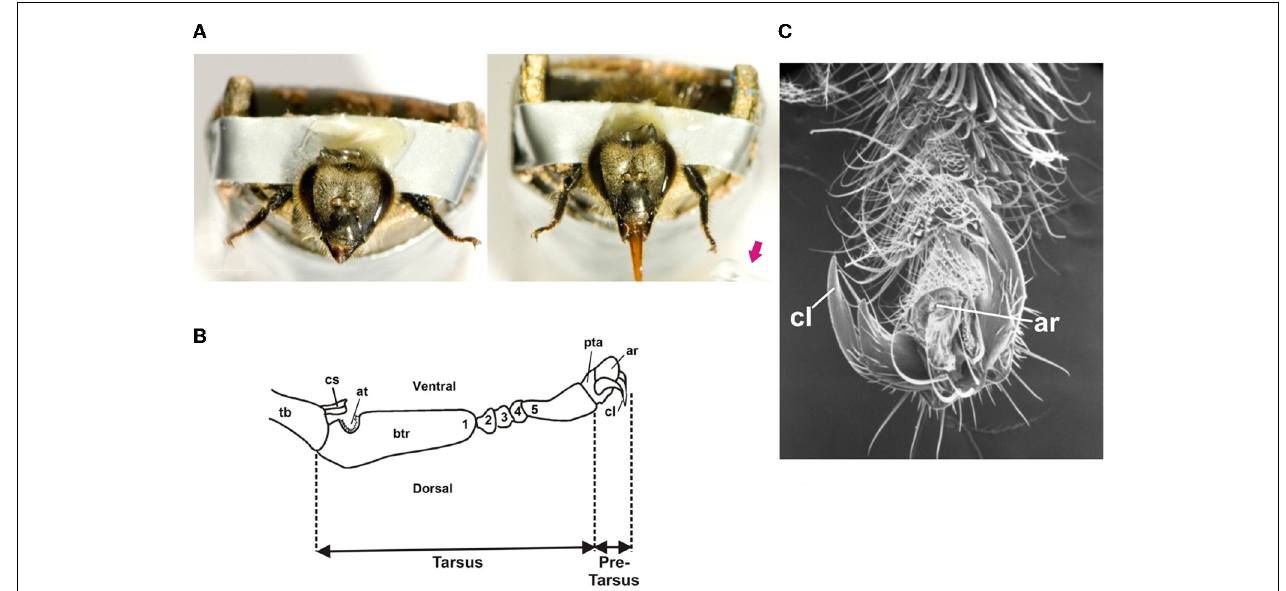
FIGURE 1 | (A) Left: Honey bee with amputated antennae harnessed in a metal tube with its forelegs fixed wide open in order to allow tarsal gustatory stimulation. Right: Proboscis extension reflex (PER) upon tarsal stimulation with a drop of sucrose solution (red arrow) delivered to the left tarsus. (B) Scheme of the distal segments of a honey bee foreleg showing the tarsus and the pretarsus. The tarsus